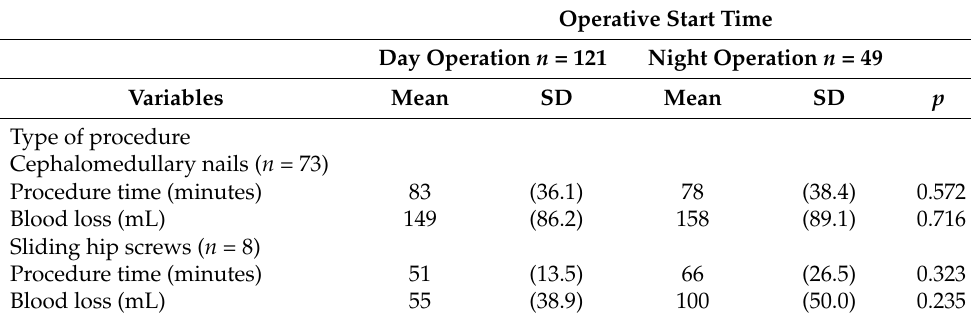
Table 2. Procedure Time and Intraoperative Blood Loss Comparison for Day and Night Operation Groups ( n =